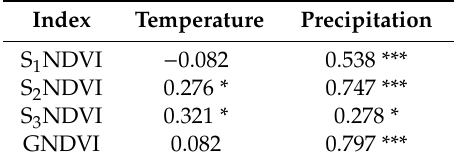
Table 5. Pearson correlation coe ffi cient between the NDVI and climate for di ff erent seasons in Xinjiang from 2000–2018.